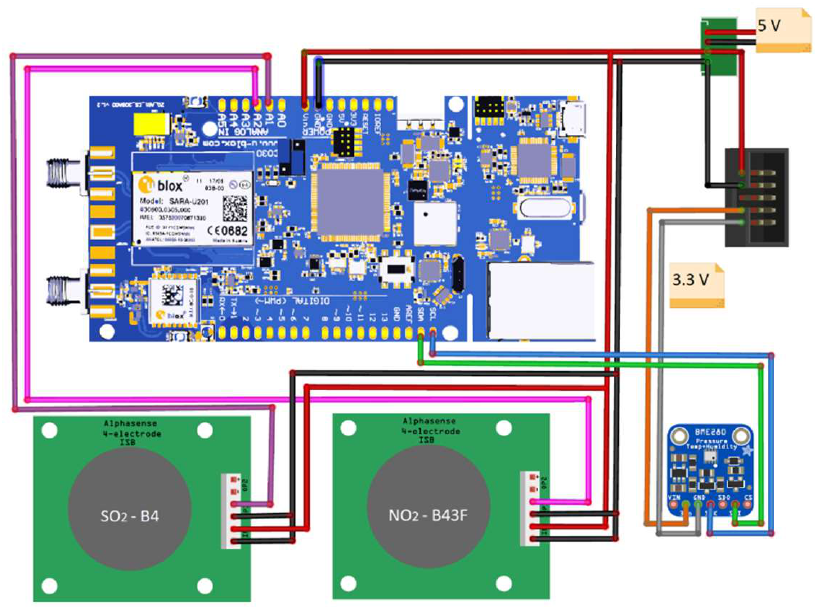
Figure 3. Module assembly and connections between the IoT controller board, sensors, and voltage regulators.